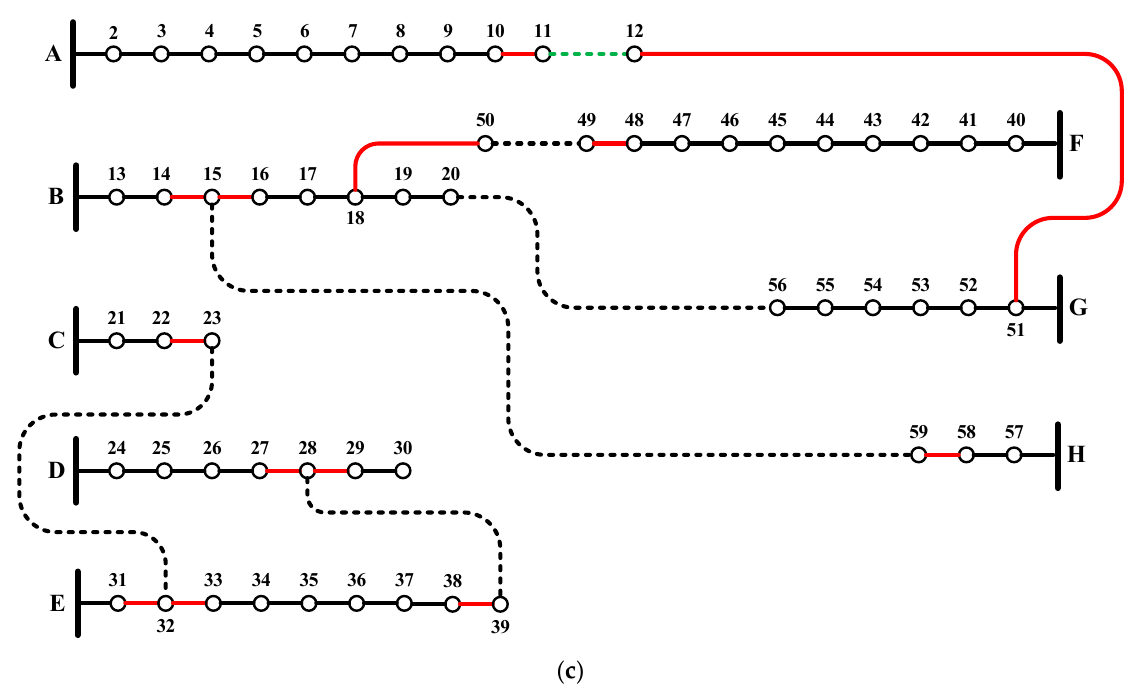
Figure 2. Reconfiguration process for the 59-node distribution network: ( a ) Initial configuration, ( b ) 1st iteration configuration, and ( c ) 2nd iteration configuration.